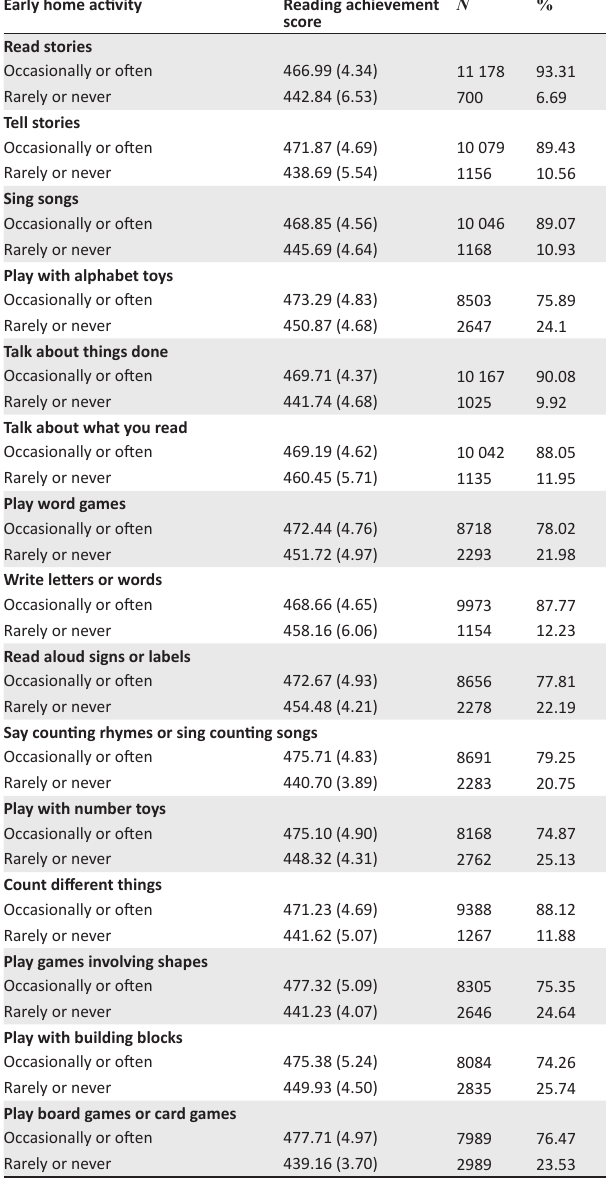
TABLE 1: Early home literacy activities means and percentages based on parents’ reporting.